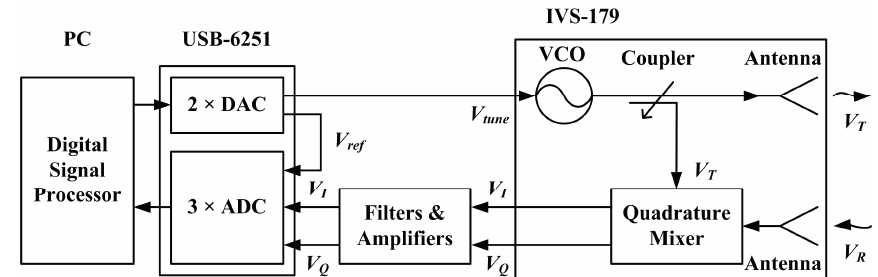
Figure 8. Actual architecture of the radar prototype.